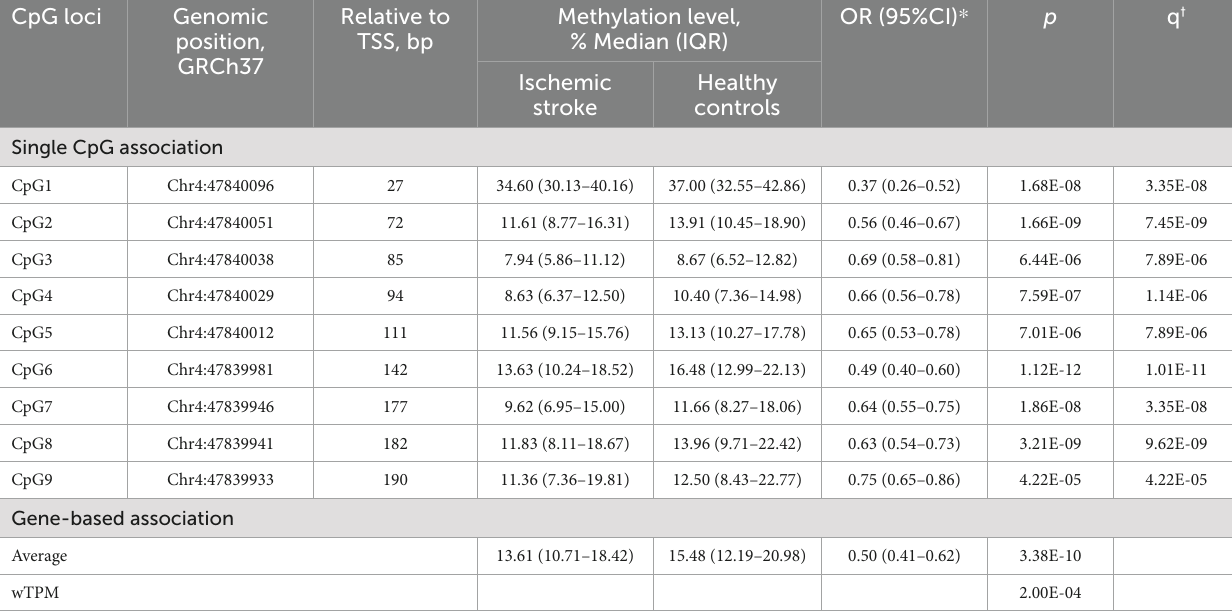
TABLE 2 The cross-sectional association between CORIN promoter methylation and ischemic stroke in the discovery sample. CpG loci